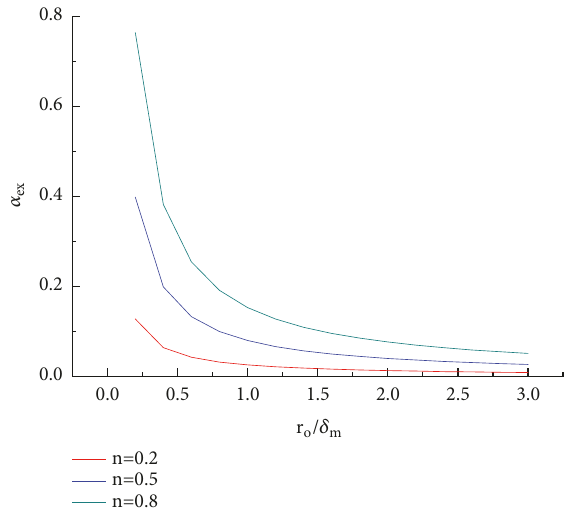
Figure 3: Variation of exchange-coupling coefficient 𝛼 ex with the ratio of r o to 𝛿 m for extended inhomogeneity.